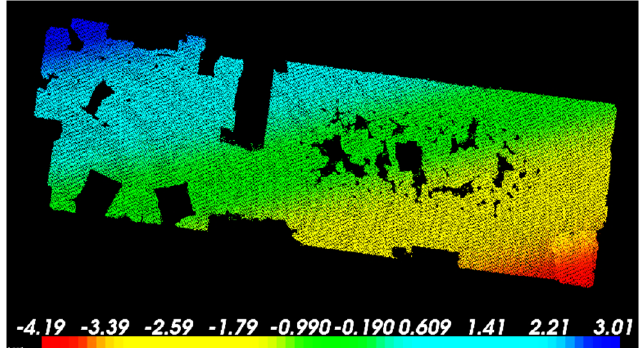
Figure 14. Ground extraction result.